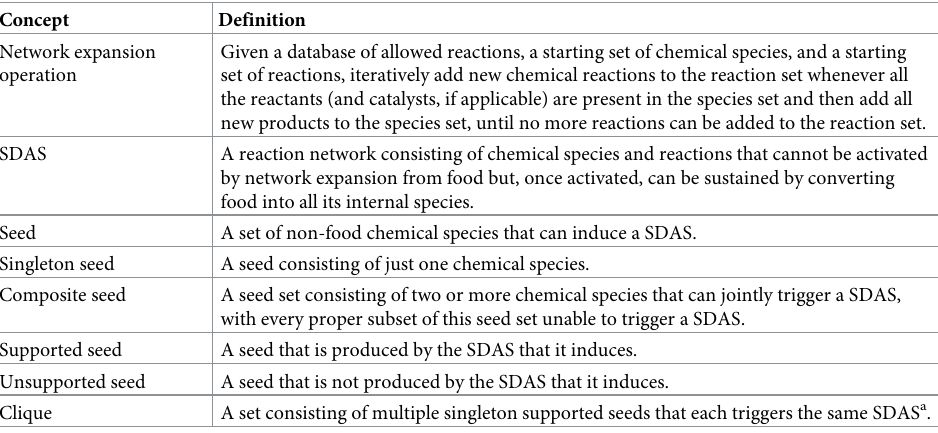
Table 1. Definitions of key